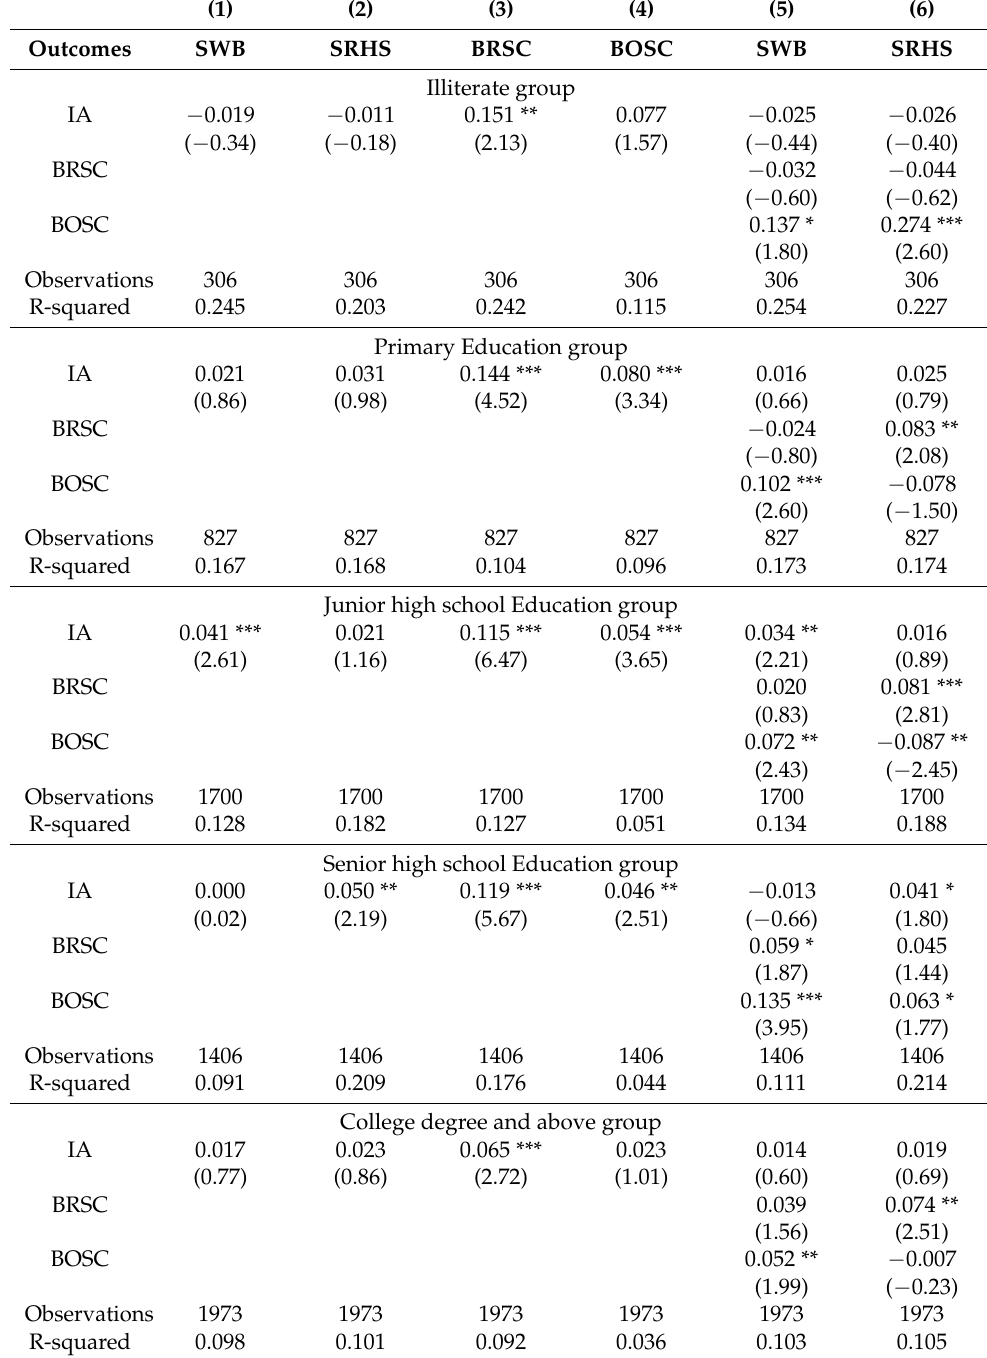
Table 6. Heterogeneous effect of